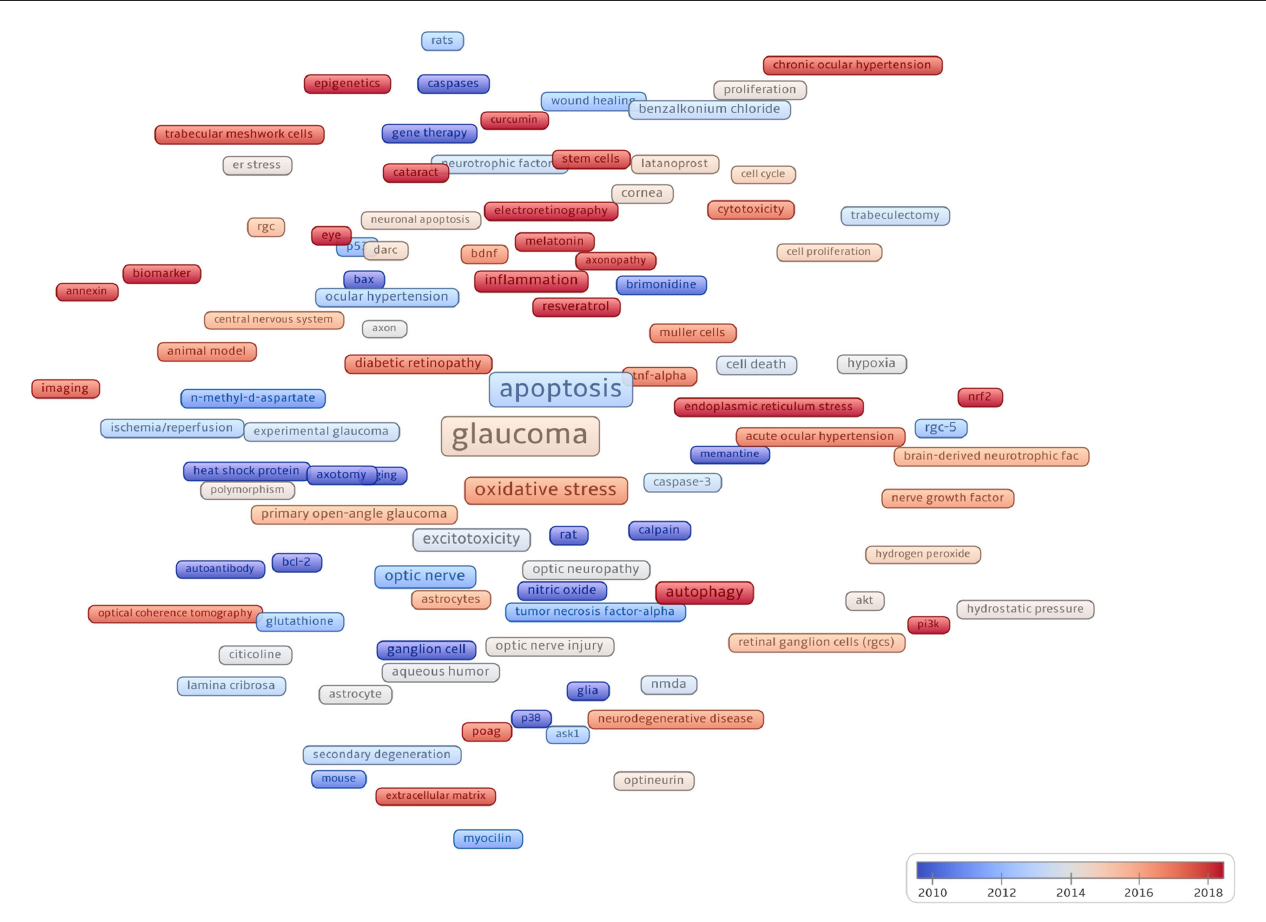
FIGURE8 Node square sizes indicate how often keywords appear, cooler colors indicate earlier occurrences of keywords, and warmer colors indicate later